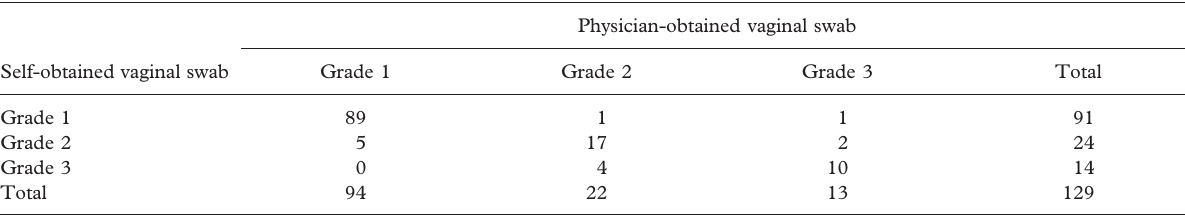
Table IV. *Comparison of Gram-stained vaginal fluid collected by the two techniques using vaginal flora scores stratified into 3 levels (grade 1, normal, 0–3; grade 2, intermediate, 4–6; grade 3, bacterial vaginosis, 7–10). Physician-obtained vaginal swab Self-obtained vaginal